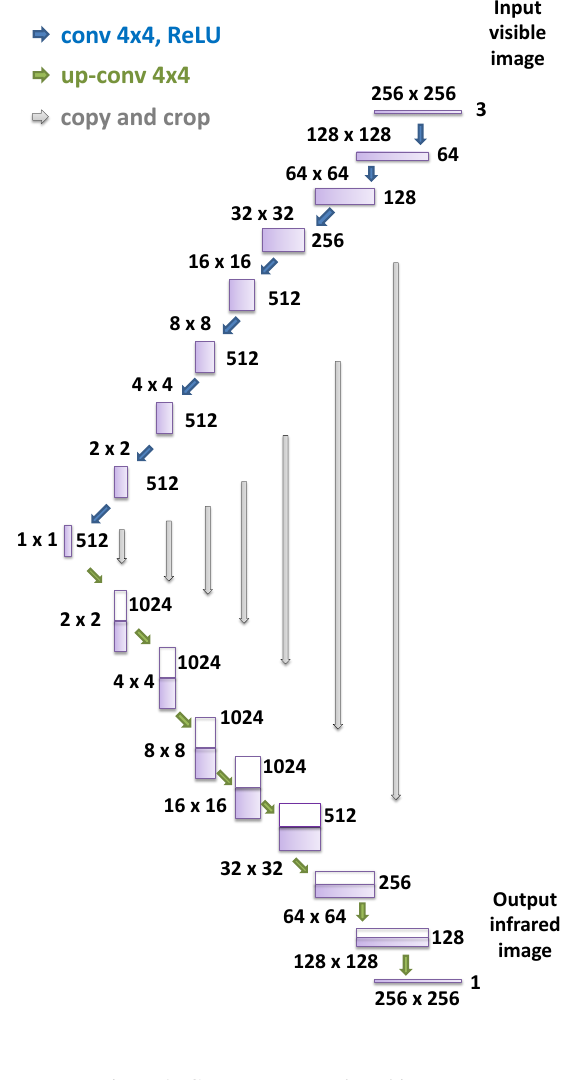
Table 1. FLIR ONE PRO camera